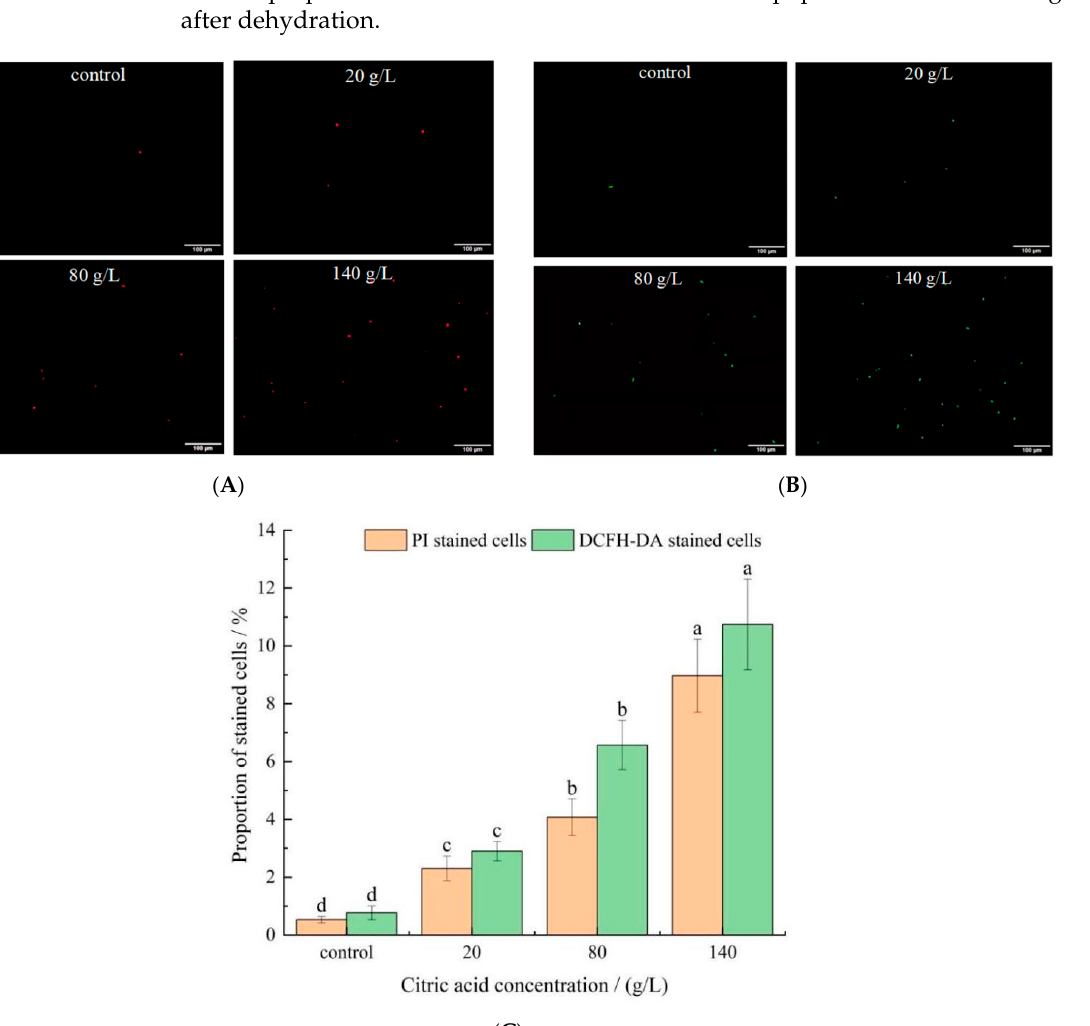
Figure 3. PI and DCFH-DA staining observation results. Error bars: SD ( n = 3). Statistically significant differences ( p < 0.05) were determined by one-way ANOVA with Duncan’s test and were indicated with different letters within each indicator. Letters correspond to the following: ( A ) fluorescence microscope observation pictures after PI staining. ( B ) Fluorescence microscope observation pictures after DCFH-DA staining. ( C ) The proportions of PI/DCFH-DA-stained cells in different citric acid concentrations of I. terricola